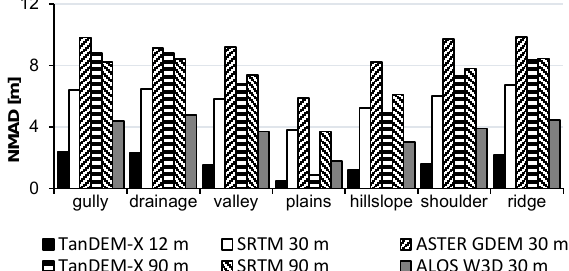
Figure 5. Calculated NMAD of elevation differences according to TPI classes classified with 12 m